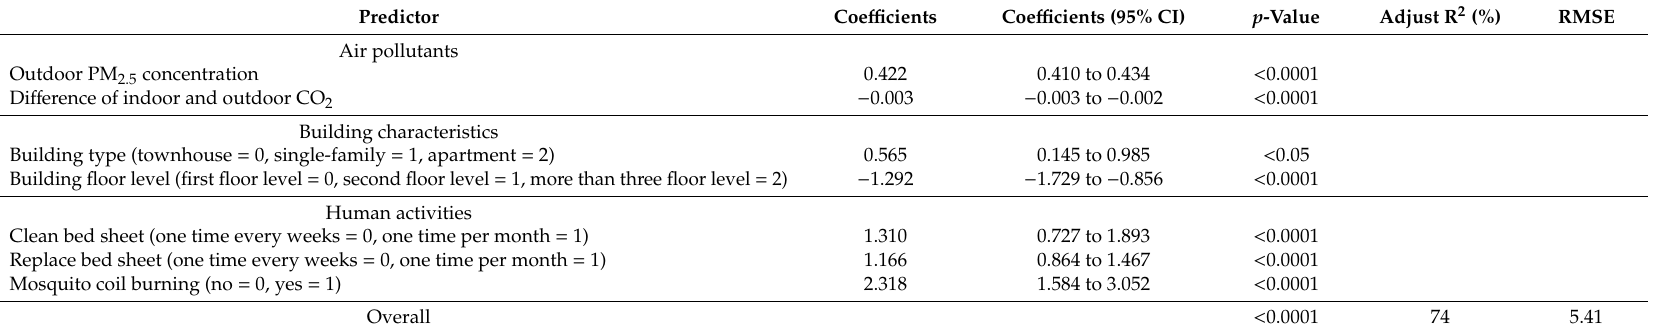
Table 4. Multiple linear regression models for hourly average indoor PM 2.5